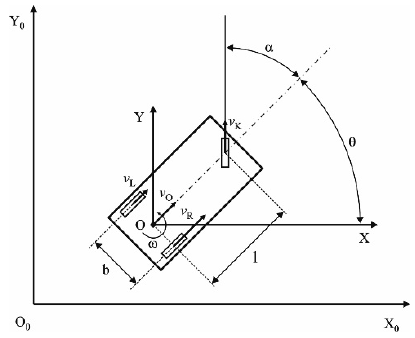
Figure 1. Vehicle movement in the reference system X 0 O 0 Y 0